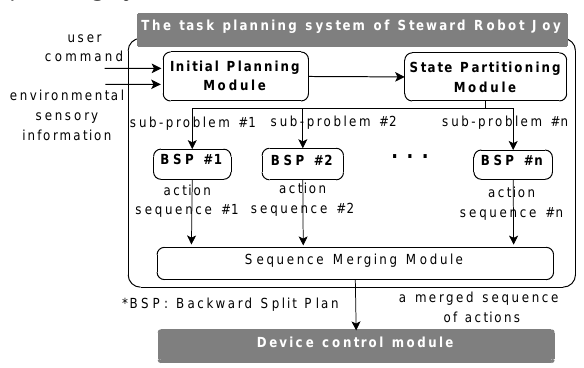
Fig. 4. Overall structure of the task planning